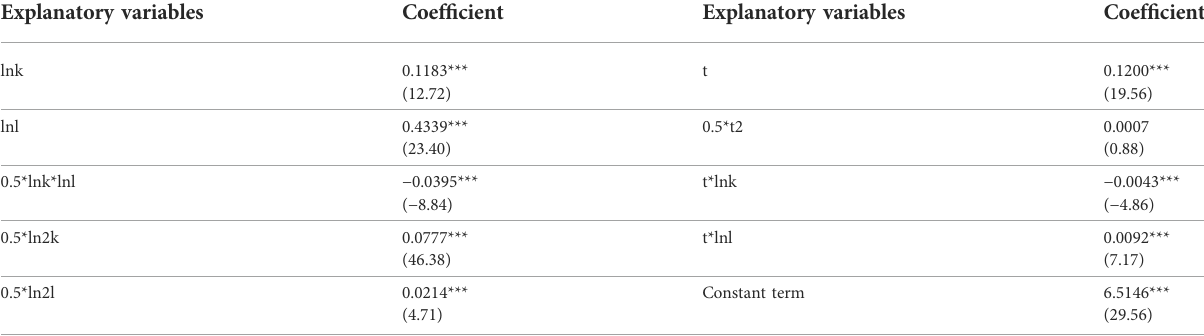
TABLE 1 Estimation results of stochastic frontier model.